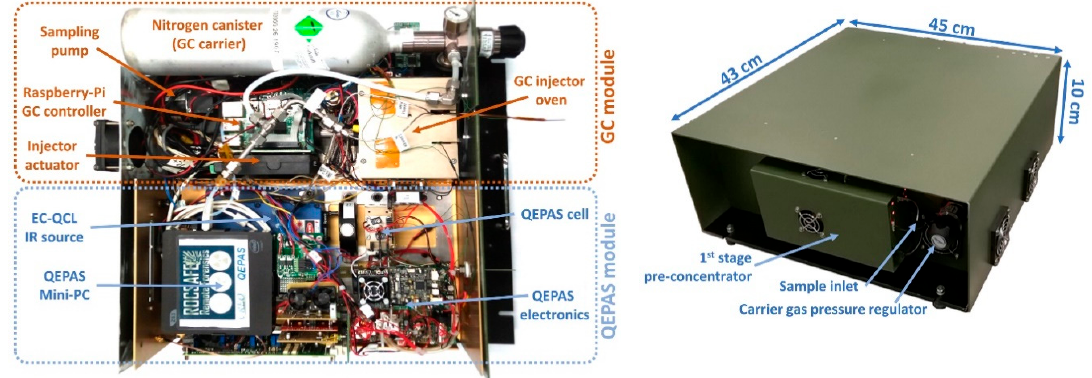
Figure 6. The complete GC/QEPAS sensor, open ( left ) and packaged ( right ).